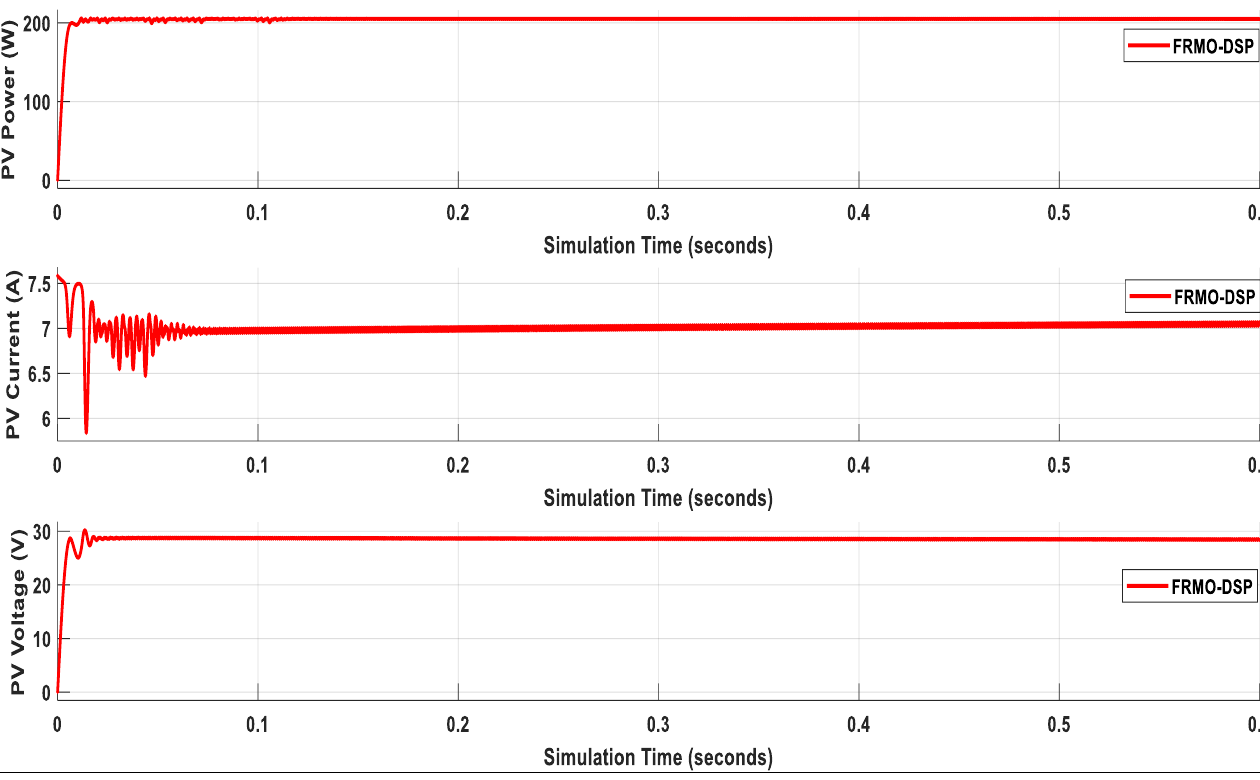
Figure 21. Case study 3 Three-phase grid voltages and current with ICLS-DSOGI-PLL.